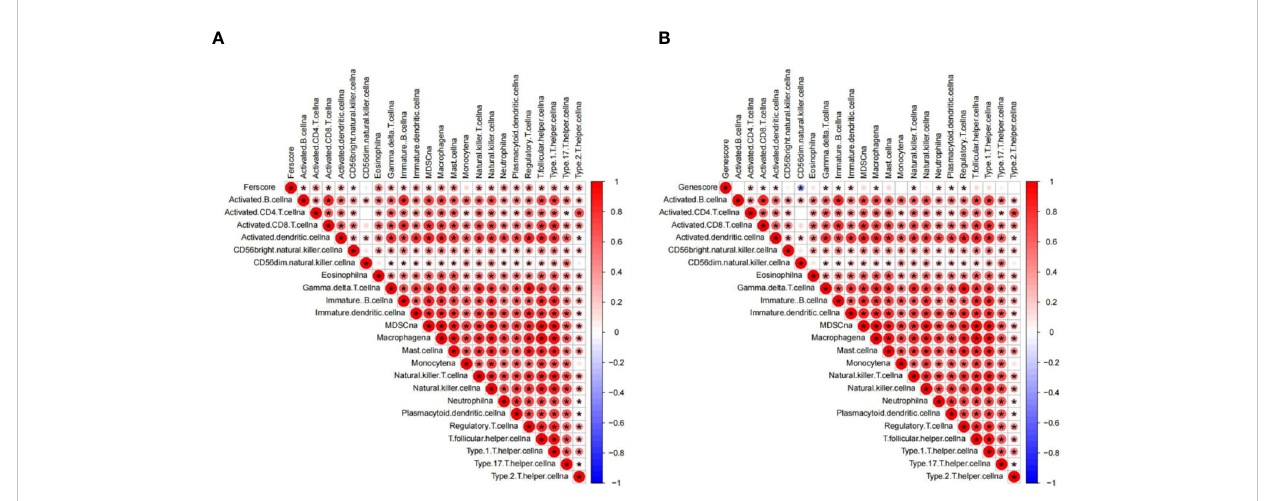
FIGURE 4 The association of immune cells and PCA score (A) and PCA gene score (B) .